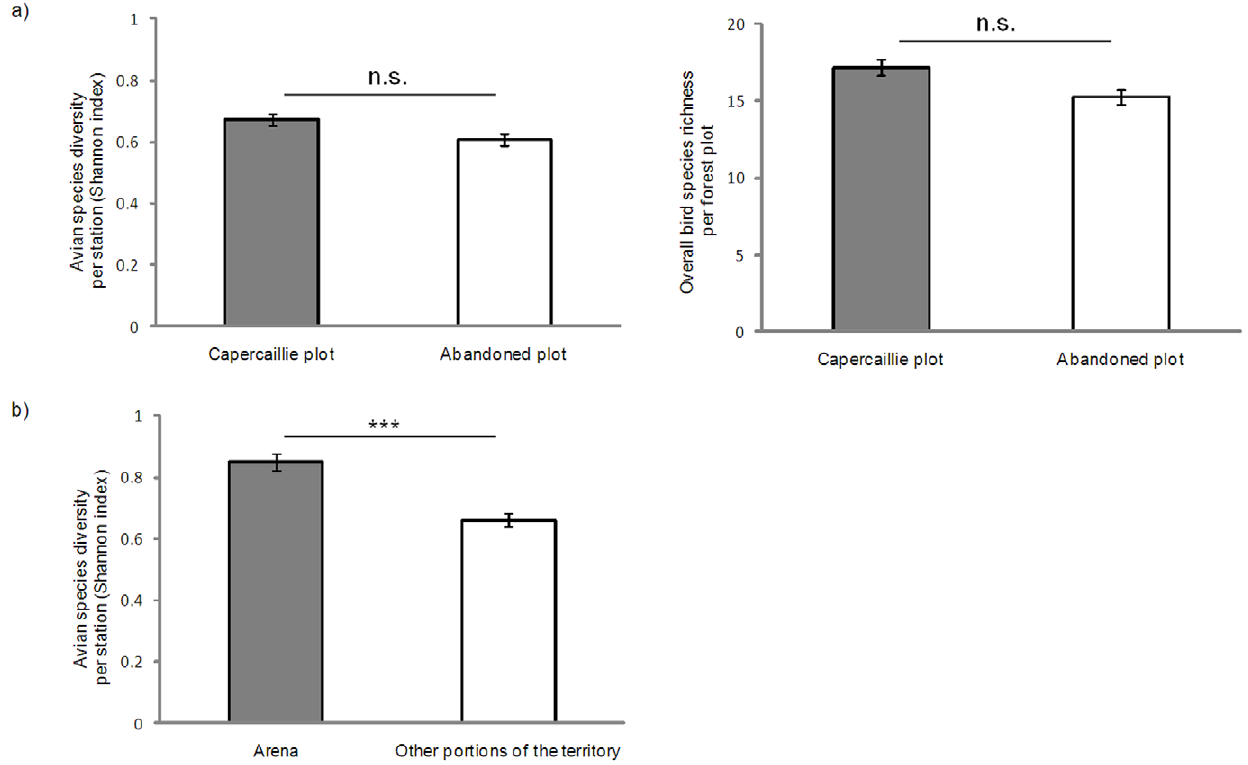
Figure 3. Bird diversity in Capercaillie plots, abandoned plots and arenas. Differences in bird species diversity per census station and overall species richness between Capercaillie plots and abandoned plots (a), and between Capercaillie arenas and other portions of its territory (b). Mean and SE are shown. *** P , 0.001.